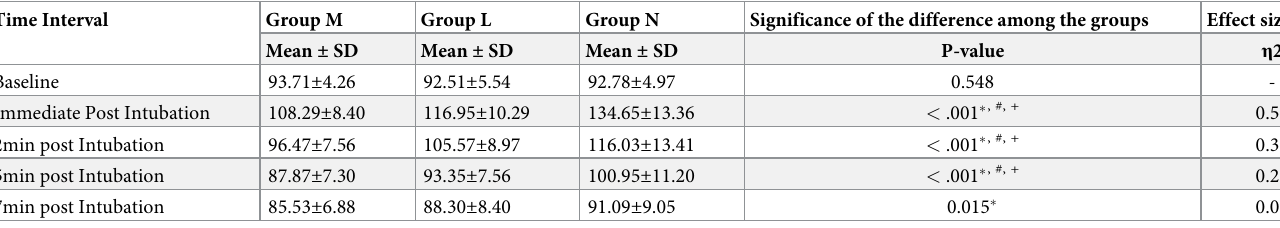
Table 5. Comparison of mean MAP among the groups and between groups at different time intervals in Zewditu Memorial Hospital, Addis Ababa, 2018/2019. Time